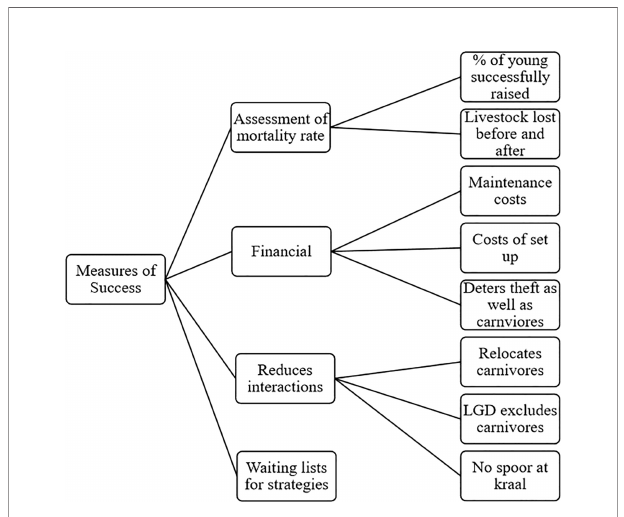
FIGURE 2 | Speci fi c stakeholder measures of success for human-carnivore coexistence intervention strategies and their